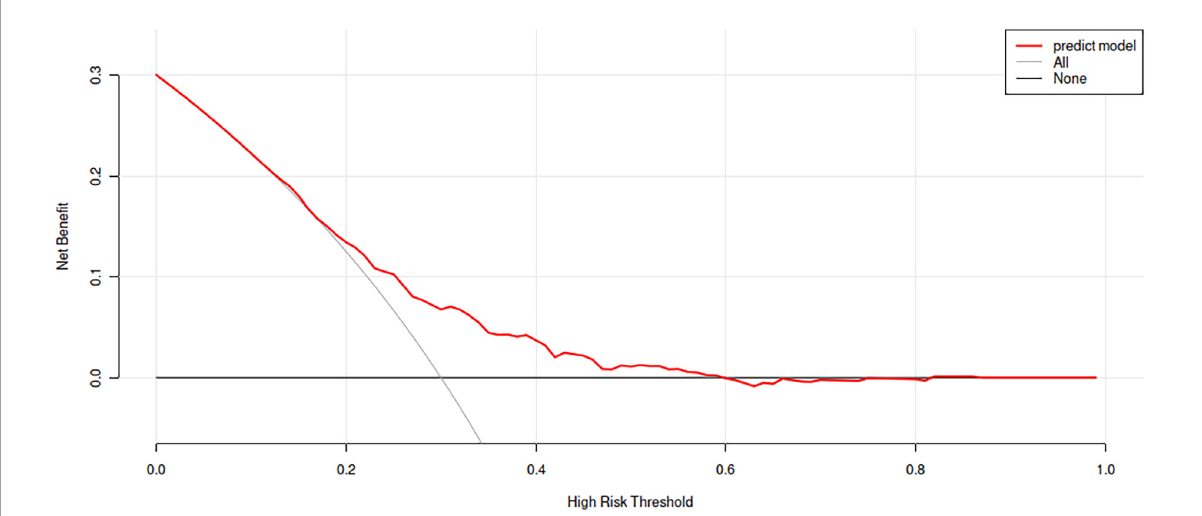
FIGURE4 Decision curve analysis for the prediction model. The horizontal line represents the net benefit without any intervention, and the oblique line represents the net benefit of intervention at all the threshold probability. The further away the curve is from these two lines, the greater benefit patients gain from the predicted